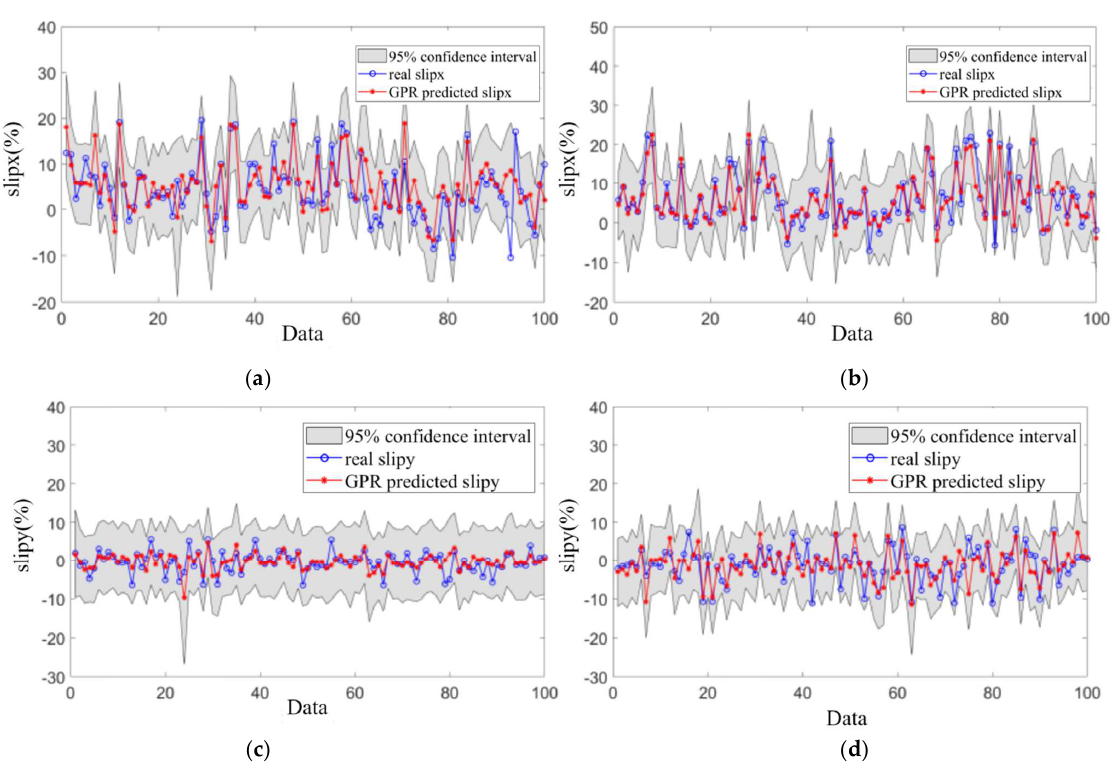
Figure 10. GPR estimation results (in part): ( a ) slip_ x on TYII−2; ( b ) slip_ x on JLU Mars−2; ( c ) slip_ y on TYII−2; ( d ) slip_ y on JLU Mars−2.